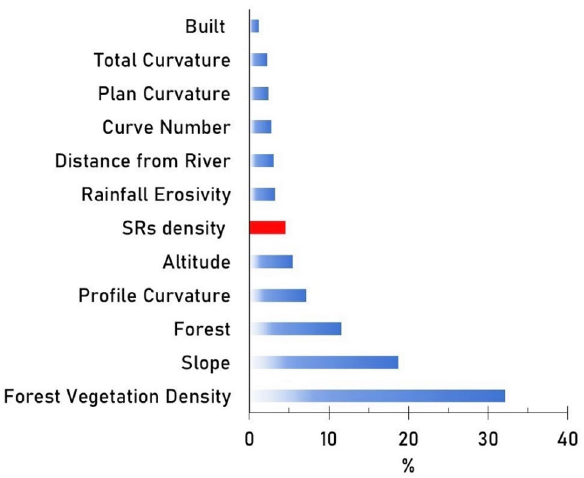
Figure 5. Conditional factors and their relative influence (%) / share/rank (%) to land degradation in the Curvature Subcarpathians region under